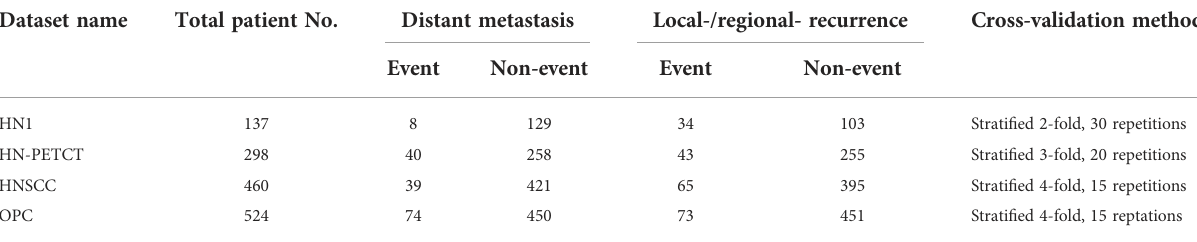
TABLE 1 The total patient numbers, patient distributions of the two binary prediction outcomes, and the train-test cross-validation methods of the screened patient cohort of the four public datasets. Dataset